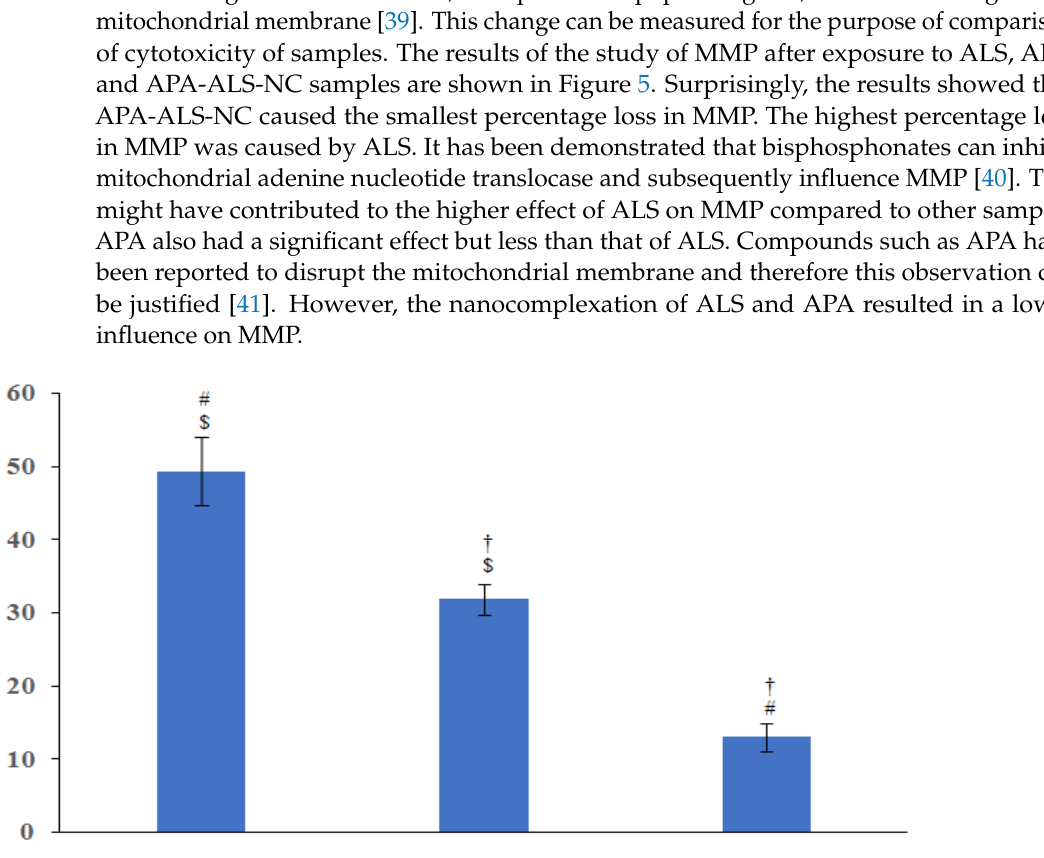
Figure 4. Cell cycle analysis results after treatment with control, ALS, APA, and APA-ALS-NC samples on PANC-1 cells. (Statistical inferences: @ p < 0.05, in comparison to control; † p < 0.05, in comparison to ALS; # p < 0.05, in comparison to APA; $ p < 0.05, in comparison to APA-ALS-NC).